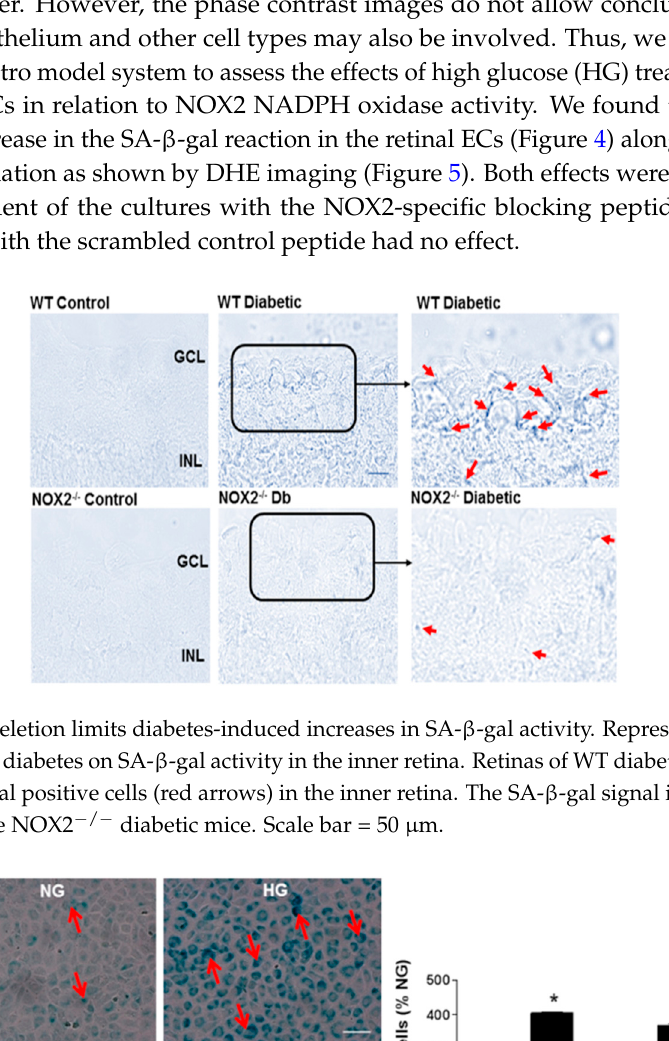
Figure 5. NOX2 blockade prevents high glucose-induced increases in oxidative stress. Representative images and statistical analysis of dihydroethidium (DHE) imaging showing effects of high glucose on reactive oxygen species (ROS) formation in endothelial cells. Treatment with high glucose (HG) markedly increased the DHE fluorescence as compared with the normal glucose controls (NG). Treatment with the NOX2-blocking peptide gp91ds-tat but not the scrambled control (SC) peptide blocked the HG-induced increase in ROS. * p < 0.05, n = 10. Scale bar = 20 µm.